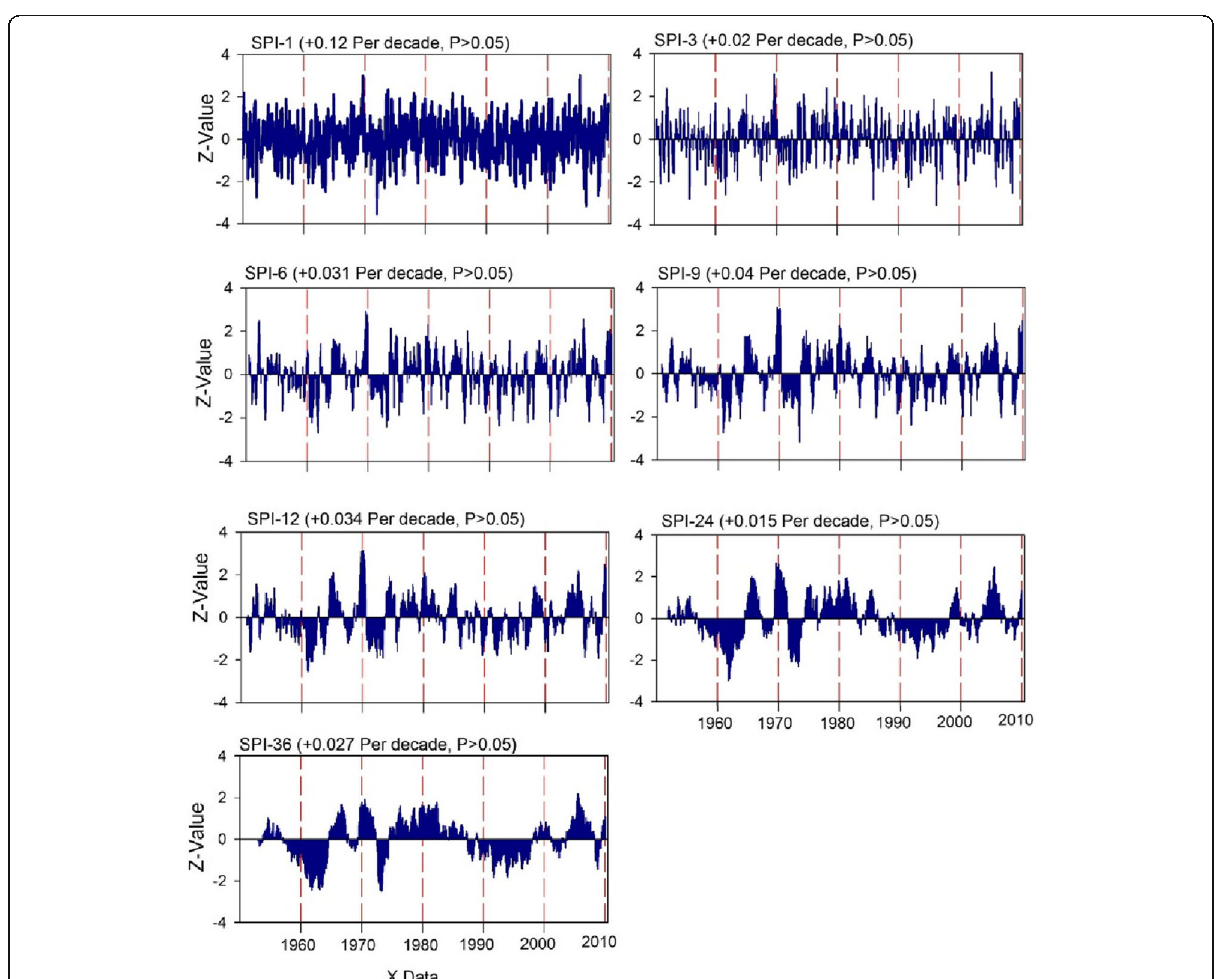
Fig. 6 SPI trends of the study area in different time scale by using smoothing